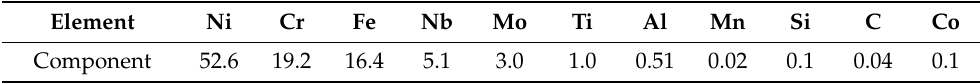
Table 1. Chemical composition of as-received GH4169 (wt.%).